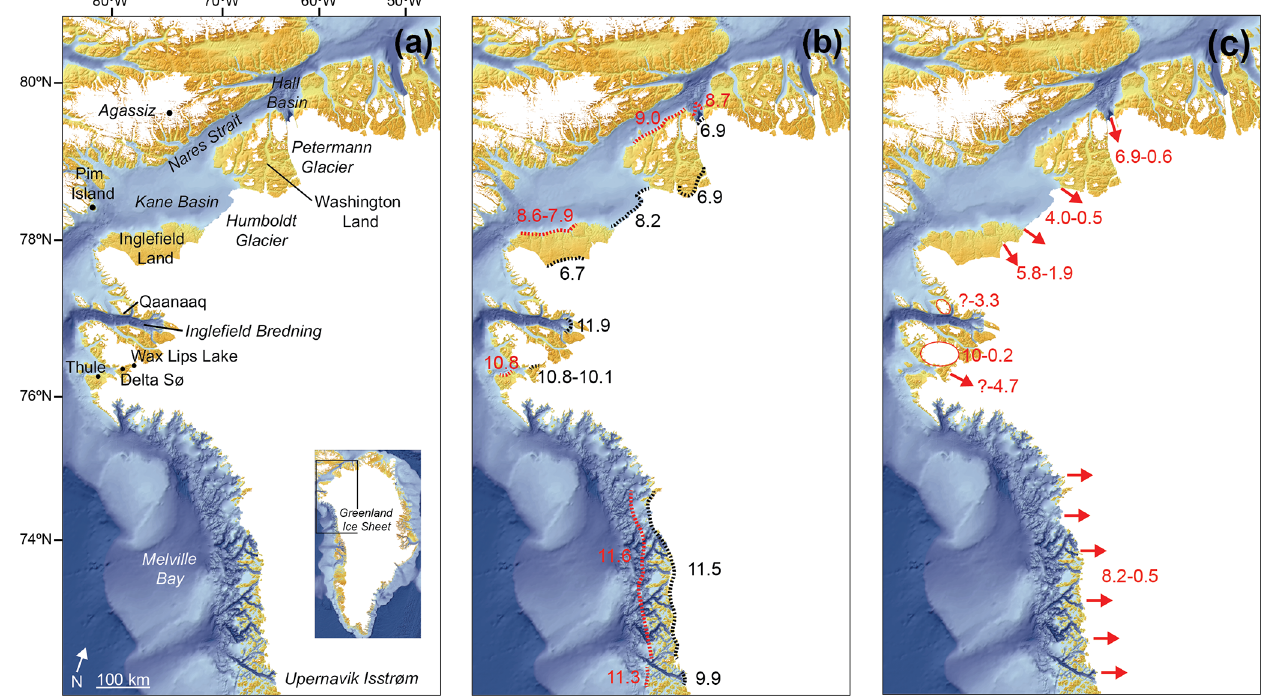
Figure 8. Age constraints (in ka) of the Holocene ice extent at the outer coast, present-day ice margin and for the period when the GrIS was smaller than present. Panel (a) shows localities in northwest and north Greenland. Panel (b) shows the initial Holocene deglaciation of the GrIS towards the outer coast (red) (Corbett et al., 2013, 2015; Jakobsson et al., 2018; Ceperley et al., 2020; Søndergaard et al., 2020) and following retreat towards the present-day ice margin (black) (Briner et al., 2013; McFarlin et al., 2018; Reusche et al., 2018; Axford et al., 2019; Reilly et al., 2019; Søndergaard et al., 2019; Ceperley et al., 2020; Søndergaard et al., 2020). Panel (c) shows the period when the GrIS and its outlets (arrows) and local ice caps (circles) were smaller than the present-day extent (Bennike, 2002, 2008; Briner et al., 2014; Farnsworth et al., 2018; Axford et al., 2019; Reilly et al., 2019; Søndergaard et al., 2019, 2020). A question mark means that the upper limit of restricted ice extent has not been